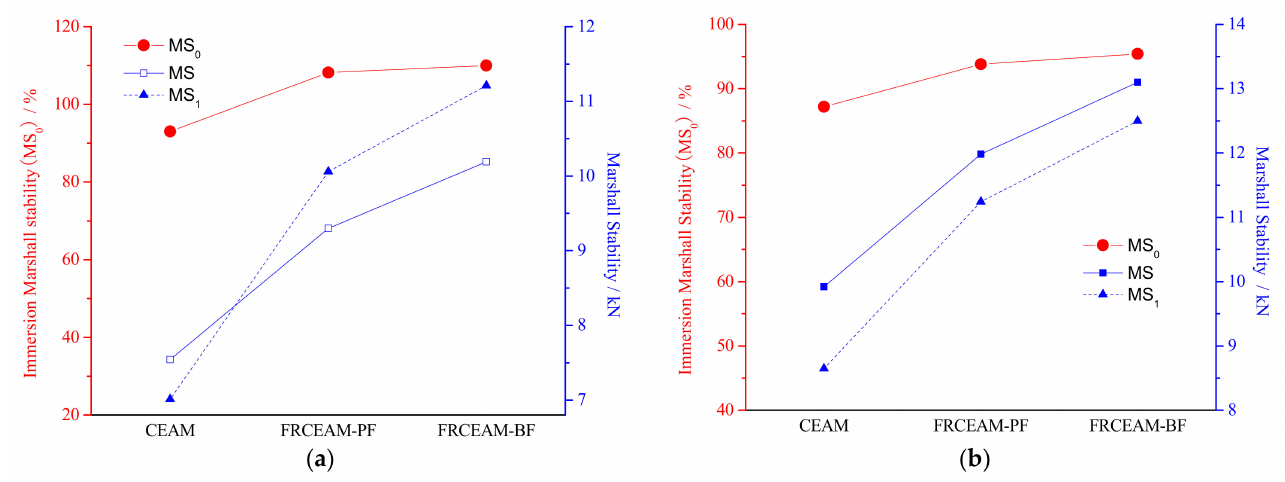
Figure 4. Marshall immersion tests results of CEAM and FRCEAM. ( a ) 7 d; ( b ) 28 d.